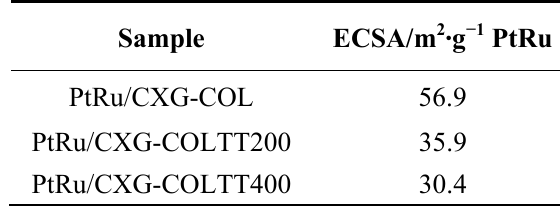
Table 4. Electrochemical active surface area (ECSA) for PtRu catalysts, determined by CO